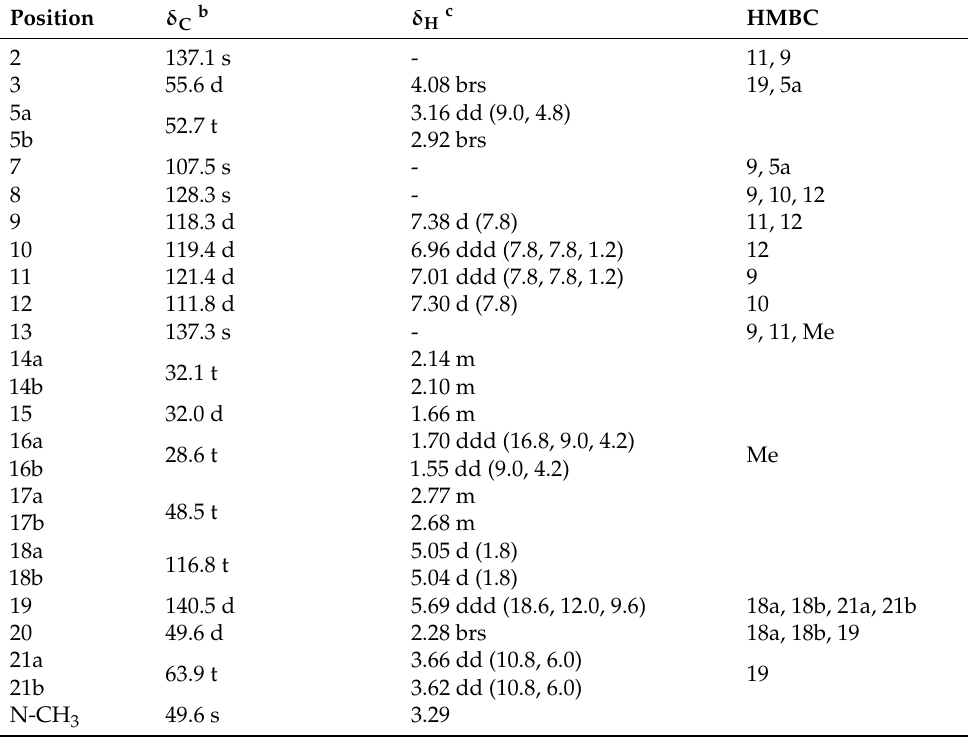
Table 1. 1 H, 13 C-NMR and HMBC of compound 1 a